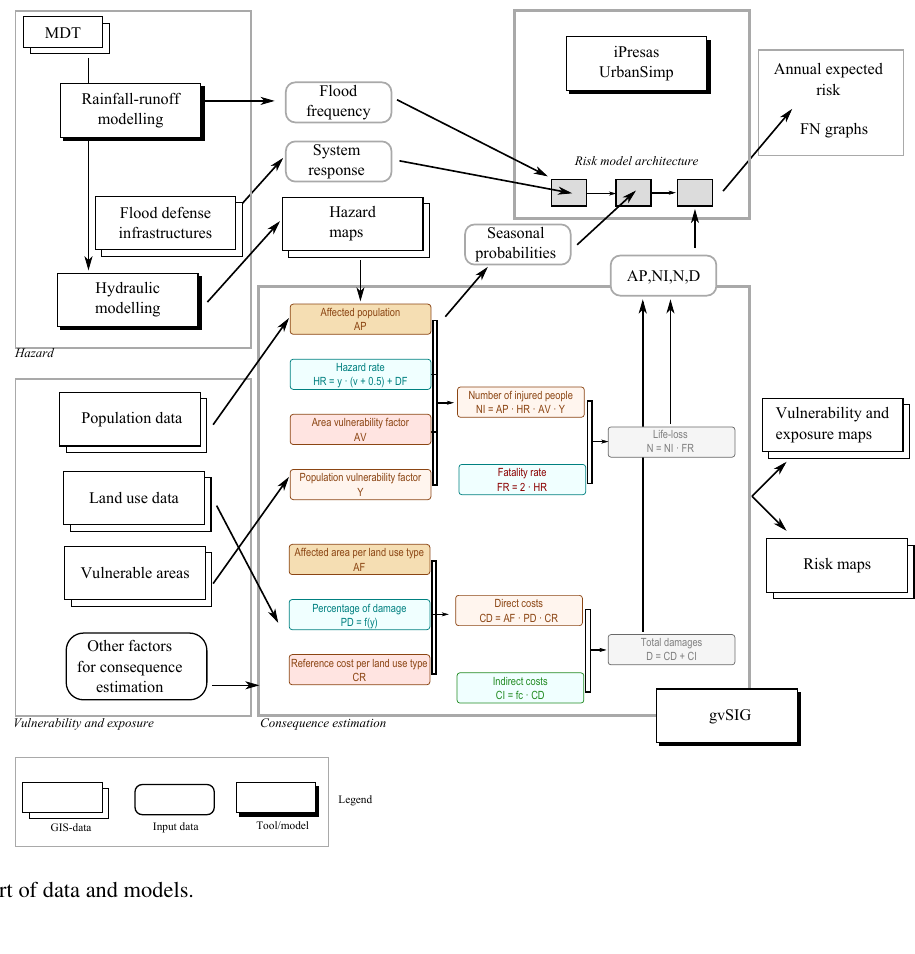
Figure 1. Flowchart of data and models.